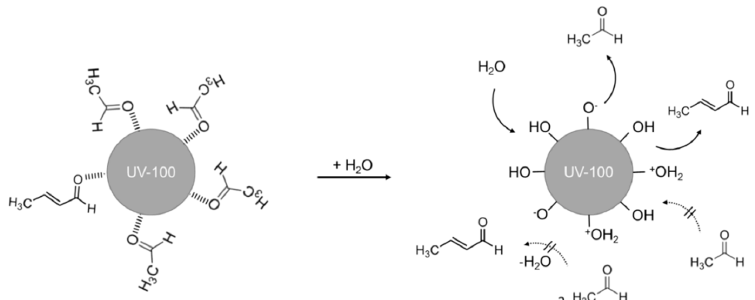
Figure 6. On the left side, the adsorption of acetaldehyde and crotonaldehyde is shown under dry conditions. Under humidified conditions, acetaldehyde was desorbed from the surface and was replaced by H 2 O molecules. Crotonaldehyde was not formed anymore, because only a minor amount of acetaldehyde was adsorbed.